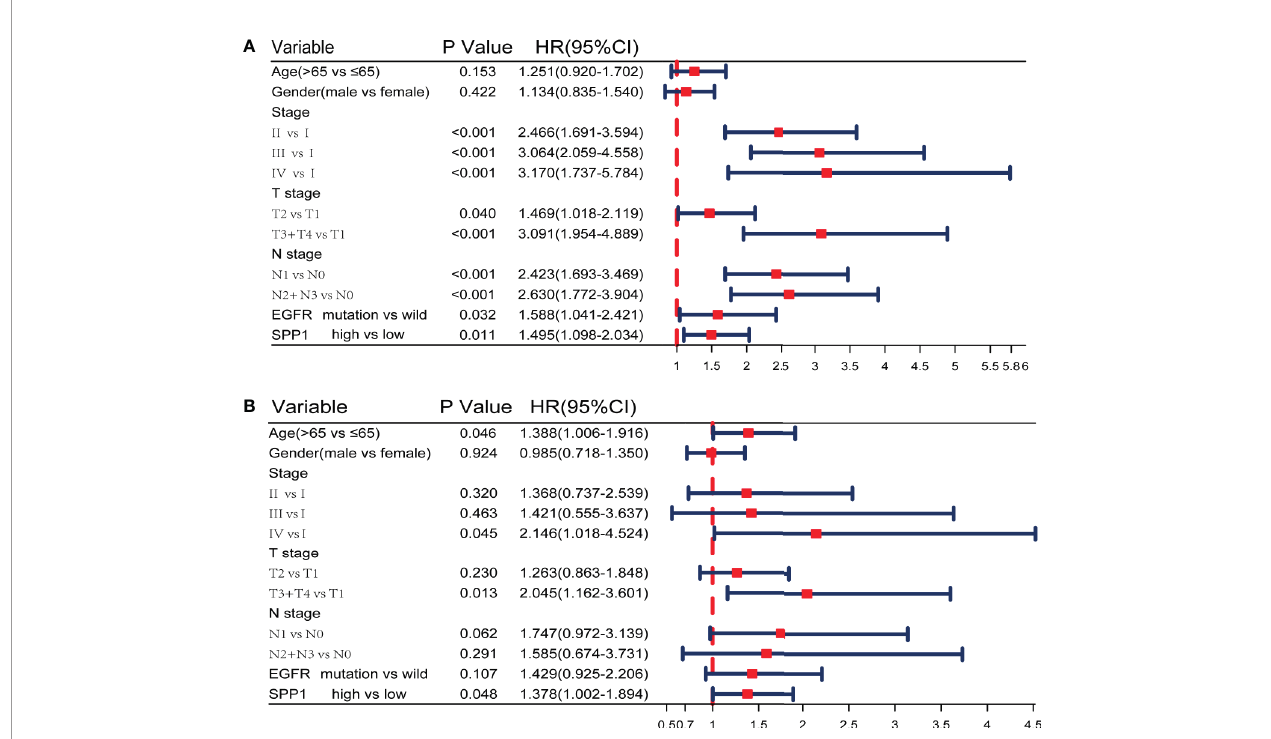
FIGURE 3 | SPP1 was an independent prognostic biomarker in TCGA. (A, B) Univariate and Multivariate Cox analysis of SPP1 expression and other clinicopathological